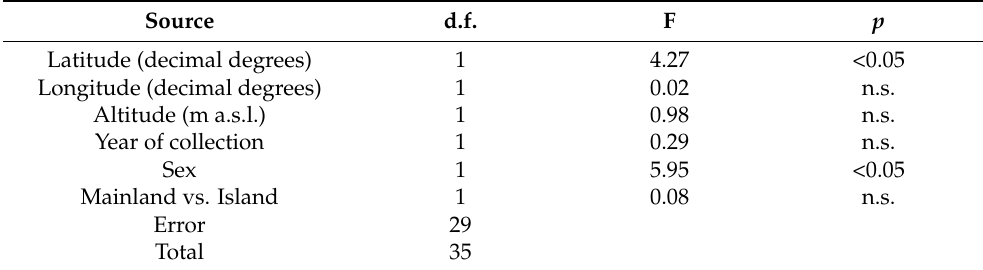
Table 1. General linear model (GLM) analysis of covariance (ANCOVA) of forearm length in 36 specimens of Rhinolophus hipposideros from Italian populations collected between 1869 and 2016. Data that did not meet test assumptions were log-transformed for analysis.